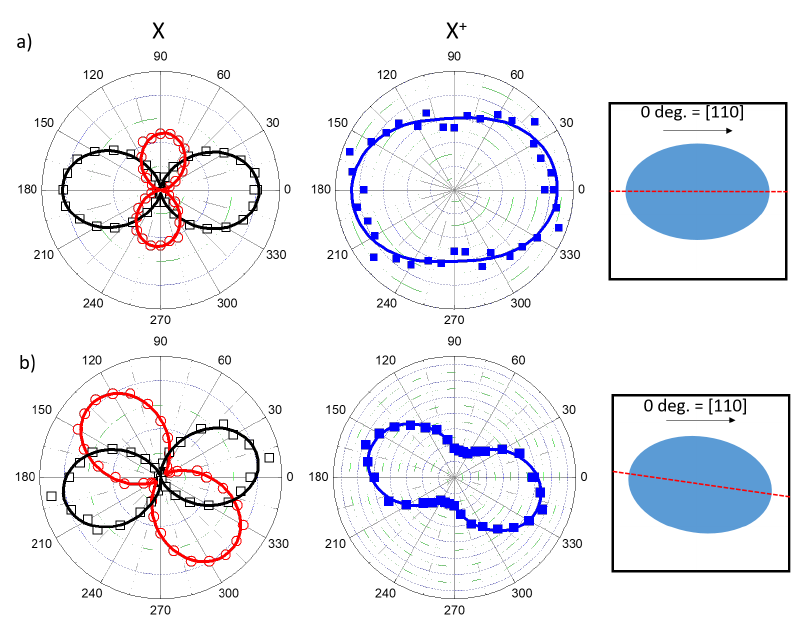
Figure 7. ( a ) Polar diagram of X PL intensity (left panel) and X + PL intensity (central panel) for a QD grown on the (001) surface for the sample described in reference [71] and having a geometrical asymmetry oriented along the main crystallographic axes, as described in the scheme reported in the right panel. ( b ) Polar diagram of X PL intensity (left panel) and X + PL intensity (central panel) for a QD grown on the (001) for the sample described in reference [71] surface and having a geometrical asymmetry axis tilted with respect with the main crystallographic axes, as described in the scheme reported in the right